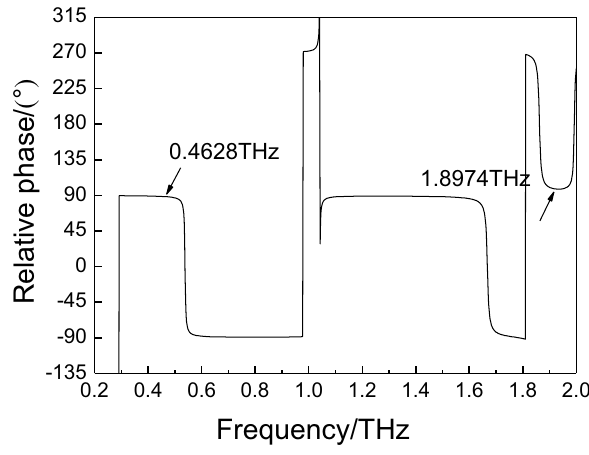
Fig. 3 Reflection phase difference of polarization